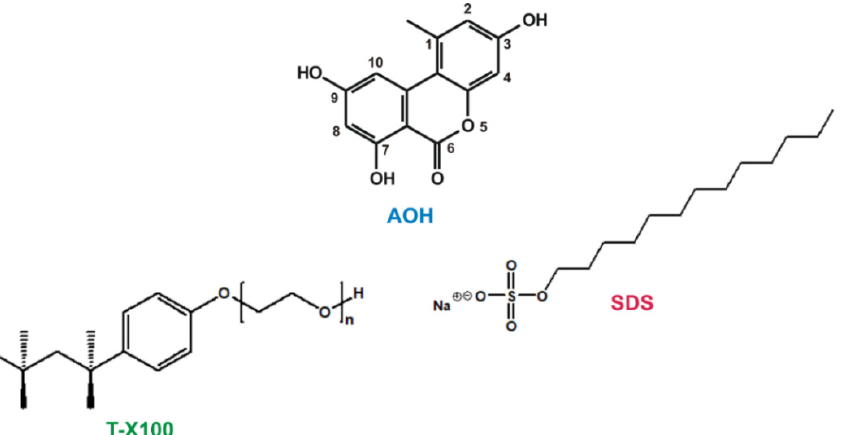
Figure 1. Chemical structures of alternariol (AOH), Triton-X100 (T-X100), and sodium dodecyl sulfate (SDS).